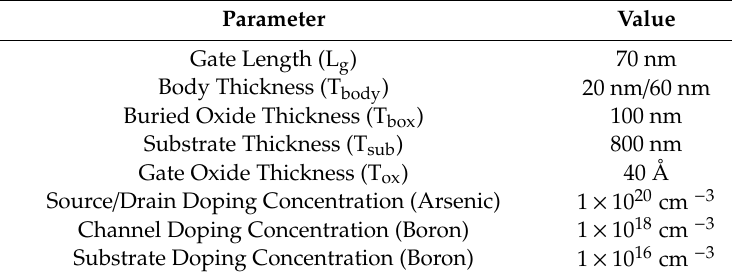
Figure1. Partsofcross-sectionsofthesimulatedstructuresoftwoone-transistordynamicrandom-access memory cells using polysilicon body (poly-Si 1T-DRAM) with di ff erent body thicknesses: ( a ) 20 nm and ( b ) 60 nm. Table 1. Device parameters for poly-Si 1T DRAM